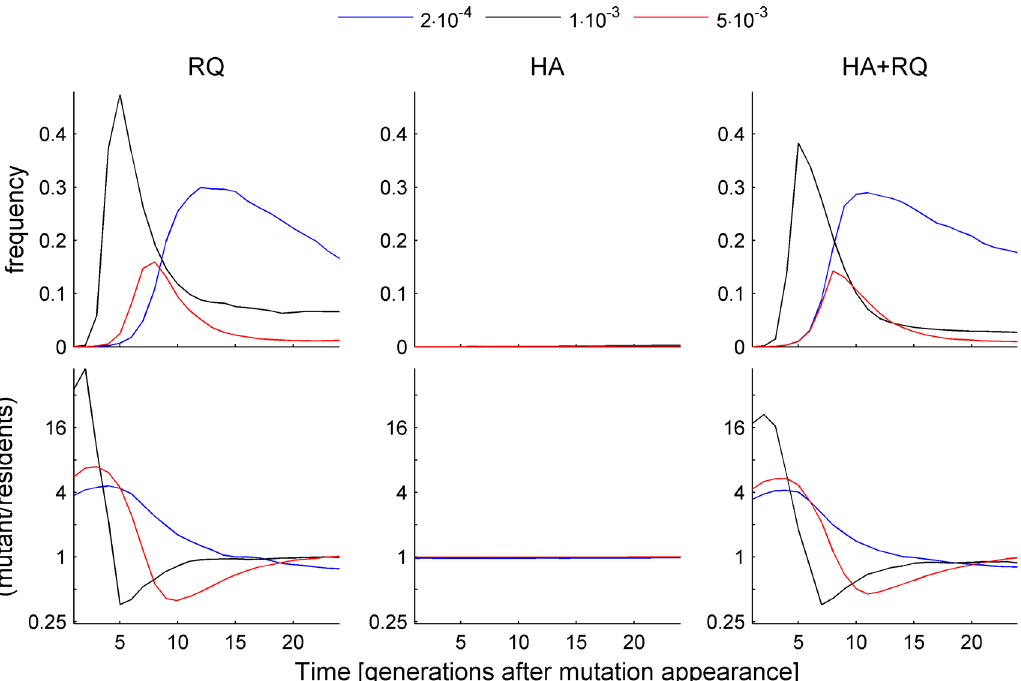
Fig 4. Frequency dynamics and presentation abilities of mutant alleles in the initial period following a mutation ’ s appearance. Panels in the upper row show averaged allele frequency dynamics over 25 generations after an allele mutation occurred under three mutation rates (see legend). Panels in the bottom row show the dynamics of median mutant allele immunocompetence in relation to the immunocompetence of resident alleles, measured as the number of pathogens presented in a given generation (weighted by the frequency of resident alleles). The measure was calculated across the last 6000 generations of 10 replicate simulations with the host population size N = 5000. Note that a presentation spectrum equal to 1 in the bottom row panels indicate the threshold at which a mutant allele is able to recognize, on average, the same proportion of pathogens as the resident alleles. For presentation purposes the scale on the Y-axis in the bottom row panels was log-transformed. Scenario labels: HA – heterozygote advantage, RQ – Red Queen, HA+RQ –